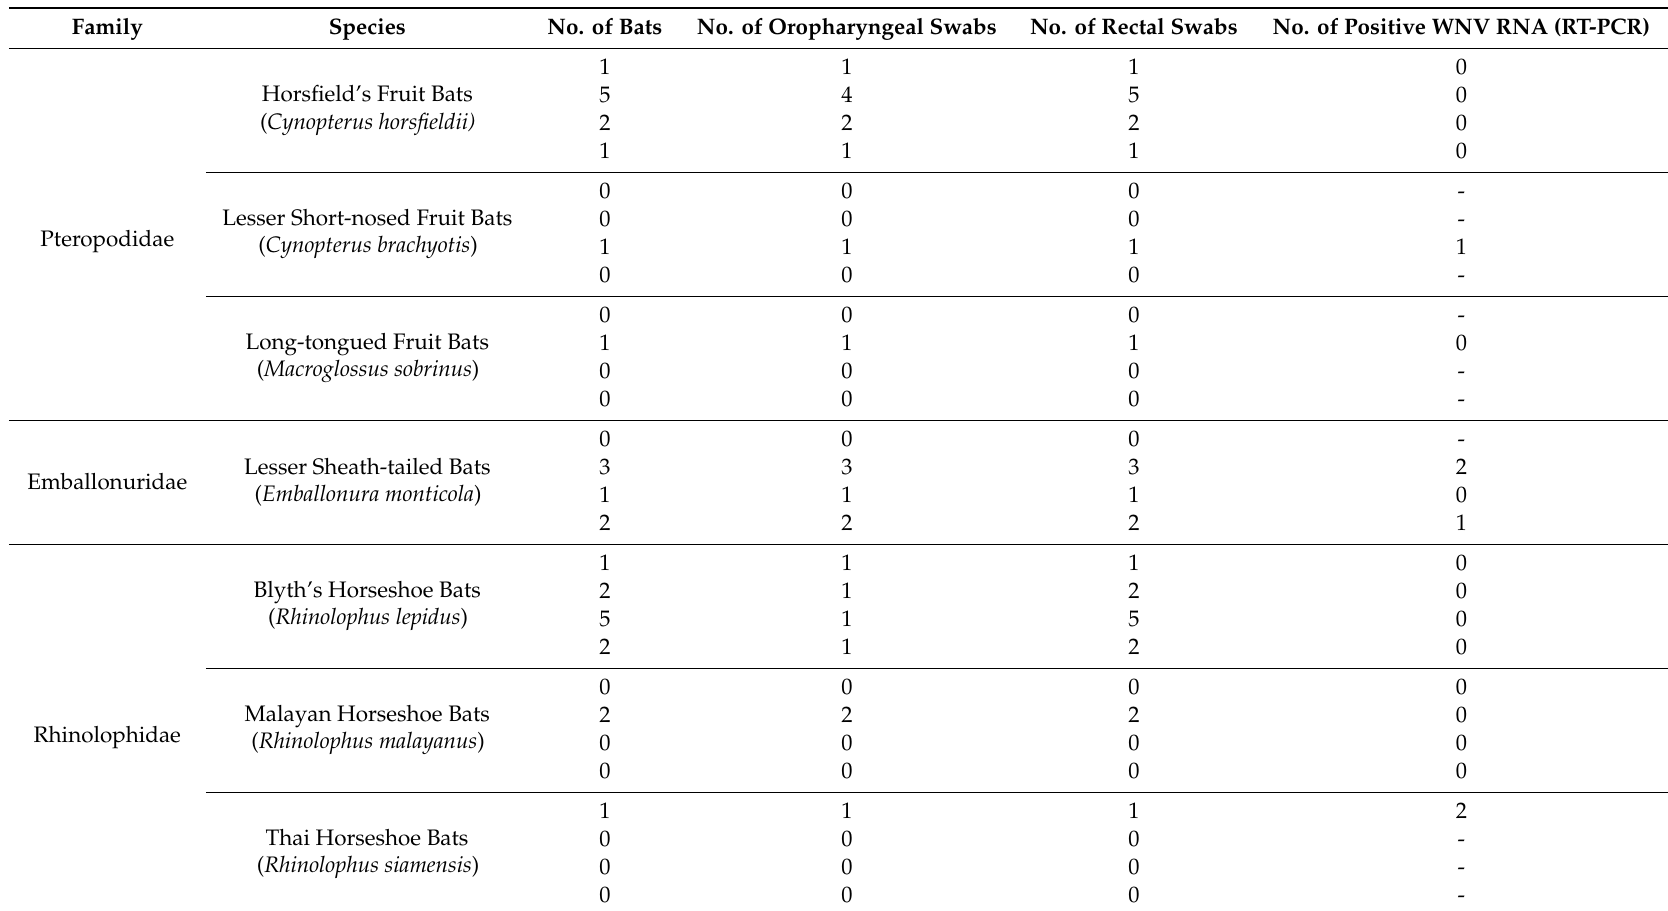
Table 2. West Nile Virus RNA detection in bats according to families, species, sex, age, and type of sample. Family Species No. of Bats